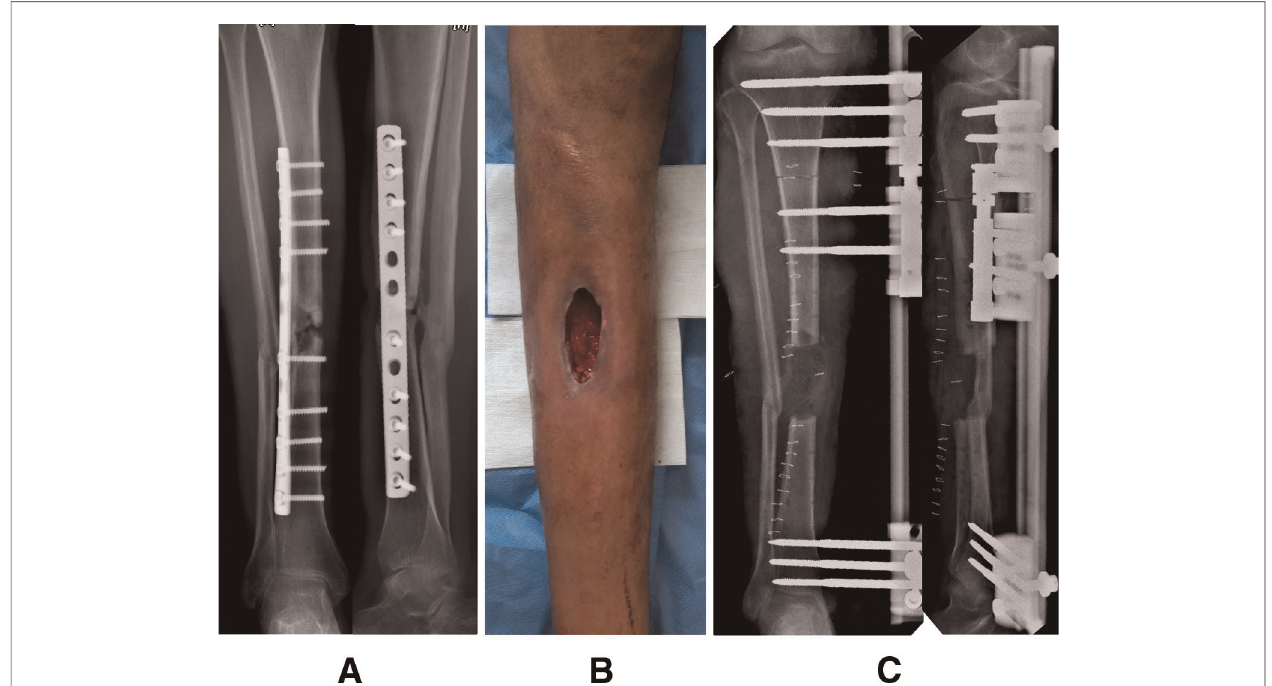
FIGURE 2 | A 42-year-old man who suffered chronic osteomyelitis in his right tibia after internal fi xation treatment followed by a road traf fi c accident and successfully treated by the bifocal bone transport (BFT) technique from proximal to distal. ( A ) Preoperative anteroposterior (AP) and lateral radiographs. ( B ) Preoperative general appearance, showing soft tissue defects with drainage and sinus. ( C ) AP and lateral radiographs immediately after radical debridement and installation of the monolateral external fi xator; there were 6-cm bone defects. A BFT technique from proximal to distal was performed to reconstruct the injured